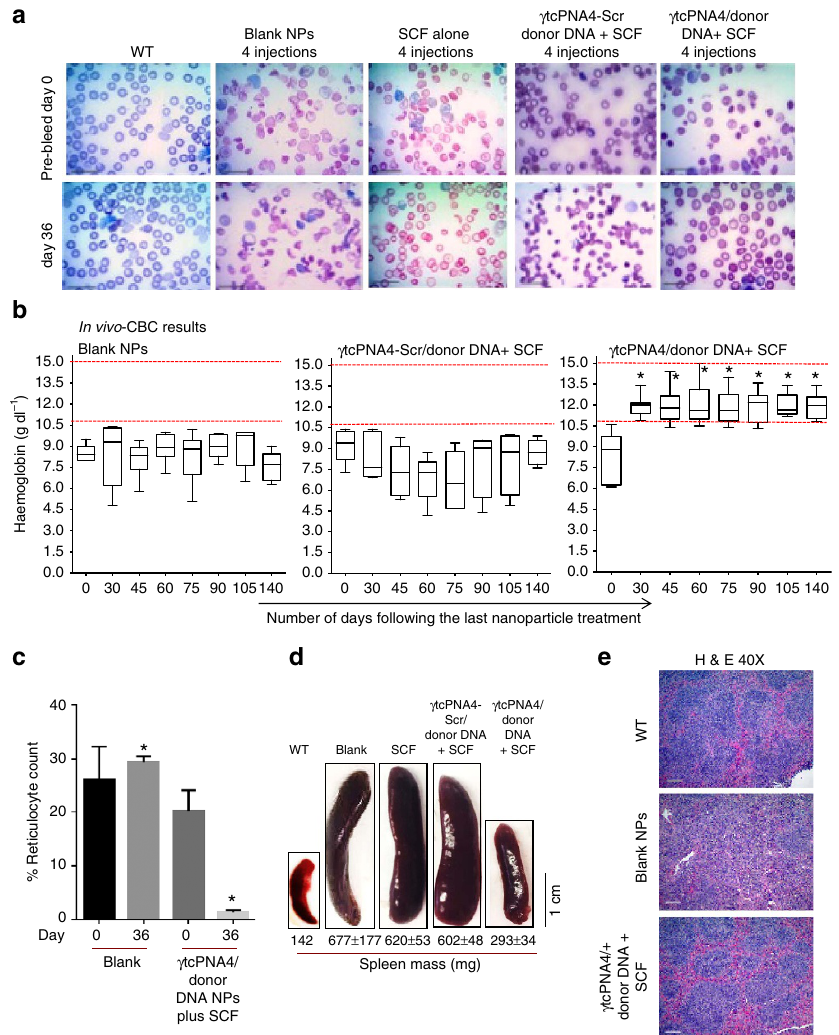
Figure 4 | Correction of anaemia in thalassemic mice by NPs containing c tcPNA and donor DNA. ( a ) Blood smears from wild-type and thalassemic mice obtained pre-treatment or 36 days after in vivo treatment with blank NPs, SCF alone, SCF plus scrambled g tcPNA4-Scr/donor DNA NPs or SCF plus g tcPNA4/donor DNA NPs. NPs were given i.v.; SCF i.p. The untreated group (and control animals) exhibit extreme poikilocytosis as well as numerous target cells, cabot rings, anisochromasia and ovalocytosis, all changes characteristic of b -thalassemia. Treatment with g tcPNA4/donor DNA and SCF ameliorates the poikilocytosis and yields a reduction in anisocytosis, ovalocytosis and target cells suggestive of reduced alpha-globin precipitation in the RBCs. Scale bar, 1.0 m m. ( b ) Blood haemoglobin levels of thalassemic mice treated with blank NPs, SCF plus scrambled g tcPNA4-Scr/donor DNA NPs, or with SCF plus g tcPNA4/donor DNA NPs performed at the indicated number of days after treatment, up to 140 days. Data are presented as box and whisker plots showing the median and quartile range within each group over time ( n ¼ 6 per group). Only the SCF plus g tcPNA4/donor DNA-treated mice achieved and maintained haemoglobin levels within the normal range during the duration of the experiment, reflecting the increased haemoglobin stability conferred by the gene editing. Horizontal bars within the boxes indicate mean; statistical analysis by Student’s unpaired t -test, * P o 0.05. ( c ) Reticulocyte counts (% of total RBCs) calculated in blood smears from thalassemic mice treated with either blank NPs or with NPs containing and g tcPNA4/donor DNA plus SCF on days 0 and 36 post treatment. Data are mean ± s.e.m., n ¼ 3; statistical analysis by Student’s t -test, * P o 0.05. ( d ) Images of spleens from wild-type mice or thalassemic mice treated with blank NPs, SCF alone, SCF plus scrambled g tcPNA4-Scr/donor DNA NPs or SCF plus g tcPNA4/donor DNA NPs at 36 days after the last treatment. Average spleen weights (with standard errors, n ¼ 3; except for wild-type, where n ¼ 1) are listed below the images. Splenomegaly is corrected only by SCF plus g tcPNA4/donor DNA treatment. Scale bar, 1.0cm. ( e ) Histopathologic analysis of spleen sections from wild-type mice and from thalassemic mice obtained 36 days after treatment with blank NPs or SCF plus g tcPNA4/donor DNA NPs. Haematoxylin and eosin stain (H&E), (cid:3) 40 magnification. Scale bar, 10.0 m m. Additional images of spleens from other treatment groups and with additional stains are presented in Supplementary Figs 17 and of 5% (albeit a different cell type). With respect to off-target effects, these publications used a PCR-based T7E1 assay, and so quantitative comparisons with our deep sequencing results are not possible. Also, these publications did not test their approaches in vivo , and so we cannot make comparisons to our in vivo results in the thalassemic mice.